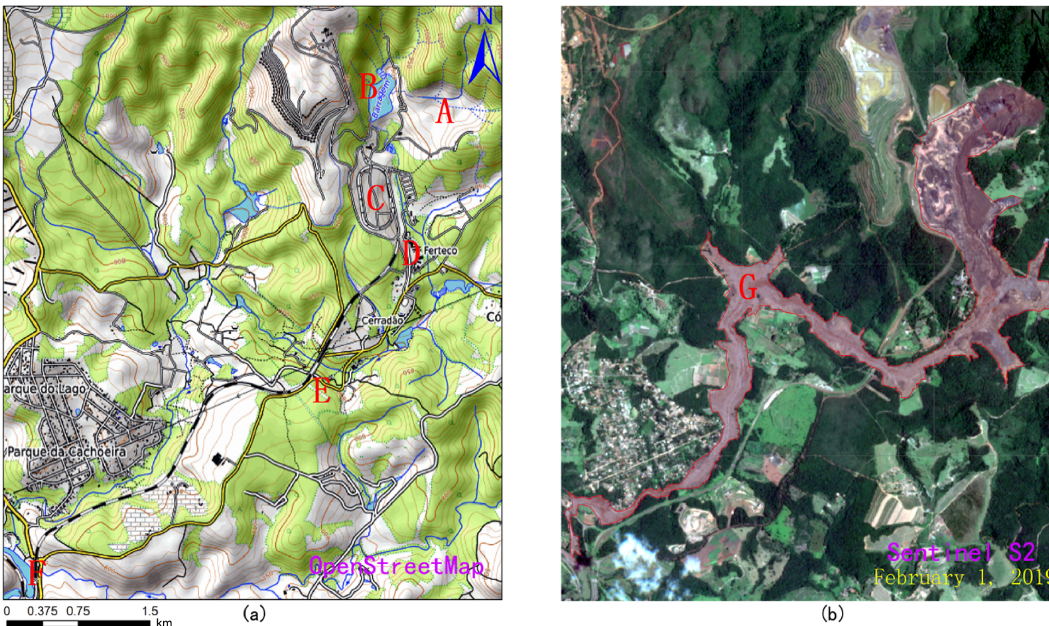
Figure 6. Location of the Feijão iron mine complex with reconstructions of the area impacted by the 2019 dam I failure event: (a) location and downstream area of the Feijão tailing dam. A – location of dam I. B – location of dam VI which was destabilized by the event. C & E – locations of the rail network and bridge. D – location of the office center and a small community. F – location of the Paraopeba River. (b) G – the destroyed downstream area. Map data: © OpenStreetMap contributors 2019. Distributed under a Creative Commons BY-SA License and Sentinel Satellite S2